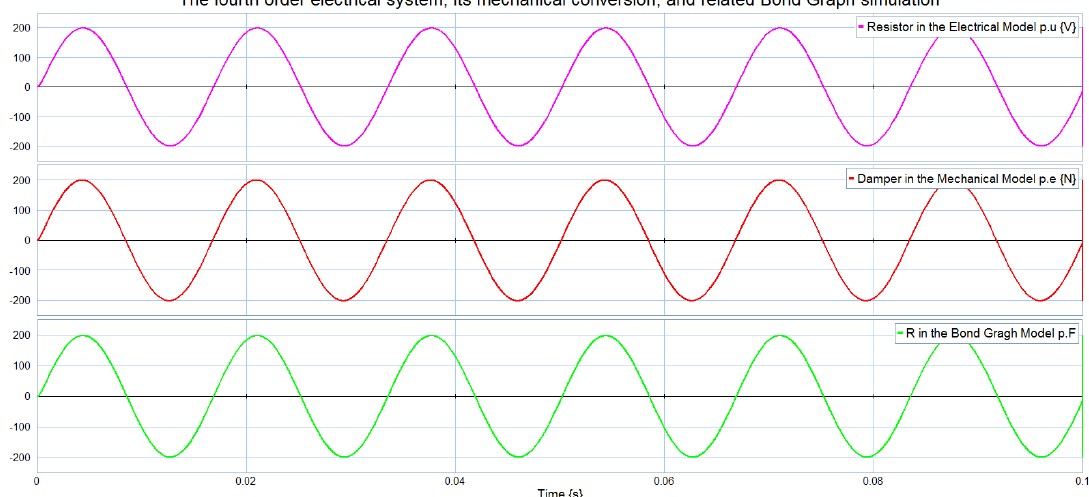
Figure 7: Simulation results: Resistor Voltage in Electrical Model (Top), Damper Force in Mechanical Model (Middle), R element effort in Bond Graph